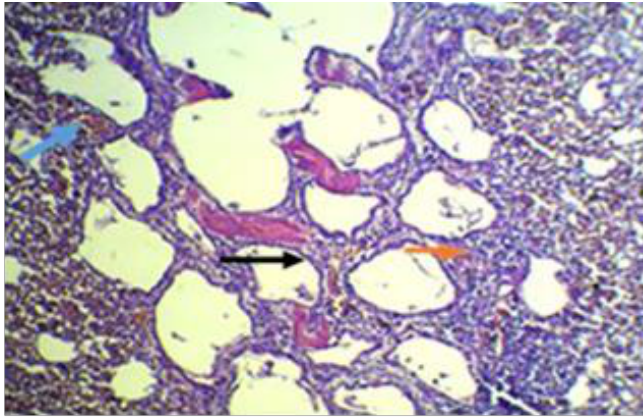
Figure 14. Histopathological section of liver shows extensive area of necrosis (